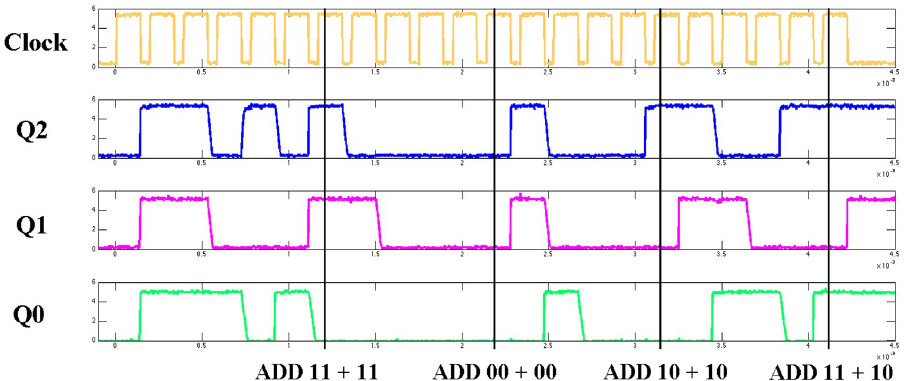
Fig 6. Observed output waveforms from NLDBM hardware. The results of four addition outputs can be observed from the outputs.